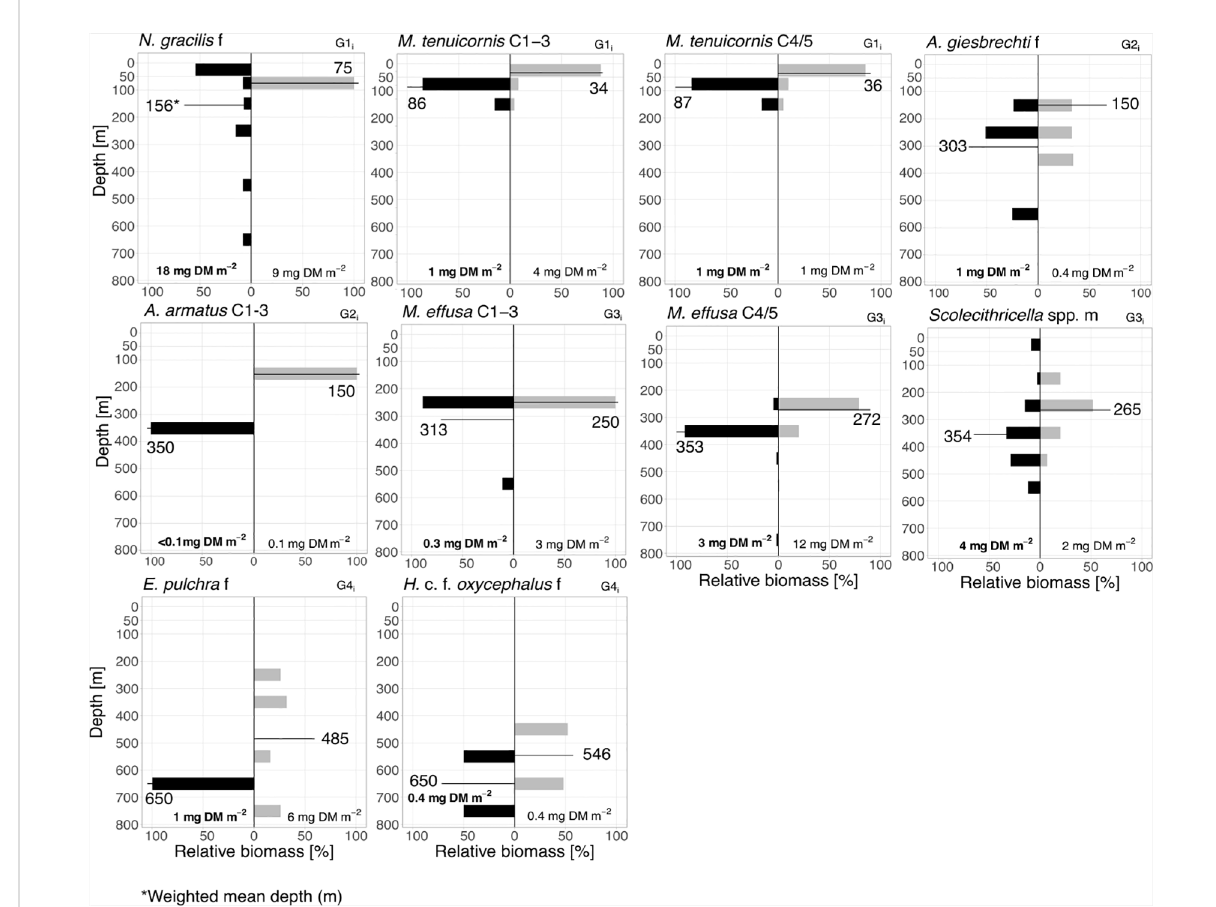
FIGURE 5 Inverse diel vertical migrants. Biomass distribution of main inverse diel vertical migrants (G1 i – 4 i ). Absolute total biomass values (mg DM m -2 ) are given for day (grey bars) and night (black bars) for each taxon. Weighted mean depths (m) for day and night of each group are